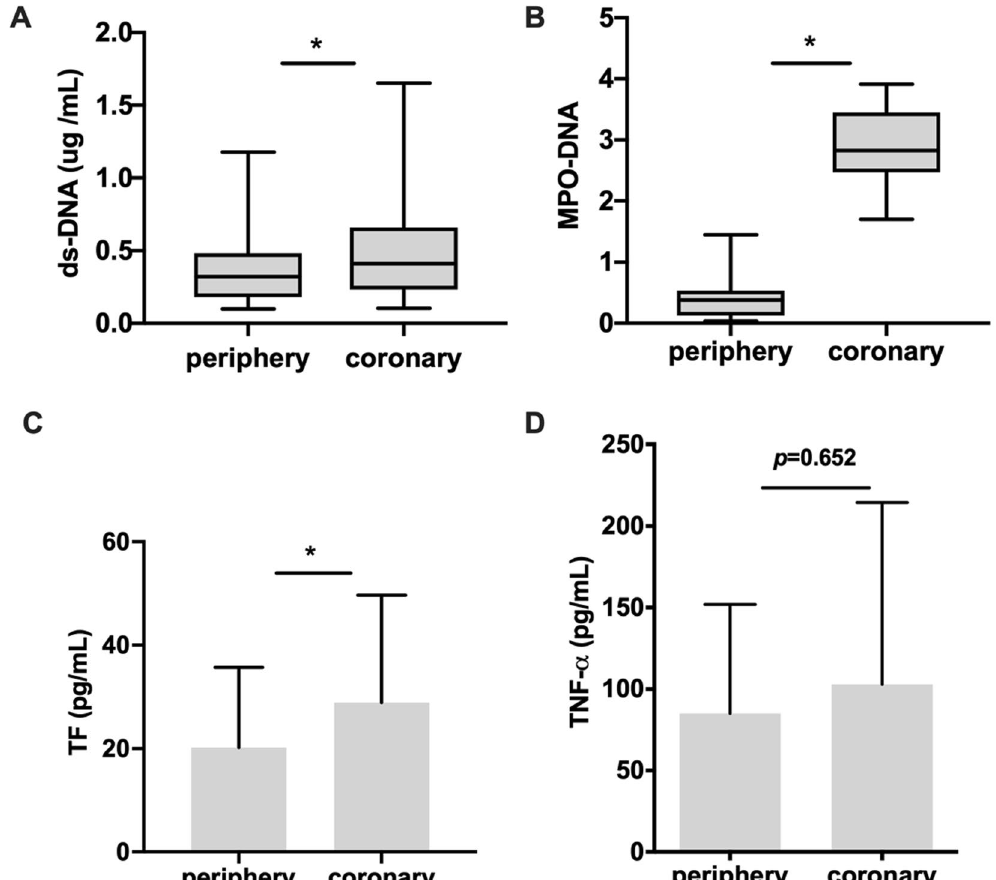
Figure 3. Surrogate Markers of NETs and NETs-related factors in infarct-related artery were higher than peripheral artery blood ( A ) ds-DNA ( B ) MPO/DNA and ( C ) TF in plasma samples from coronary arteries increased compared with peripheral arteries. ( D ) There was no significant difference for TNF- α between coronary and periphery blood.All figures demonstrate as mean ± SD, * P <